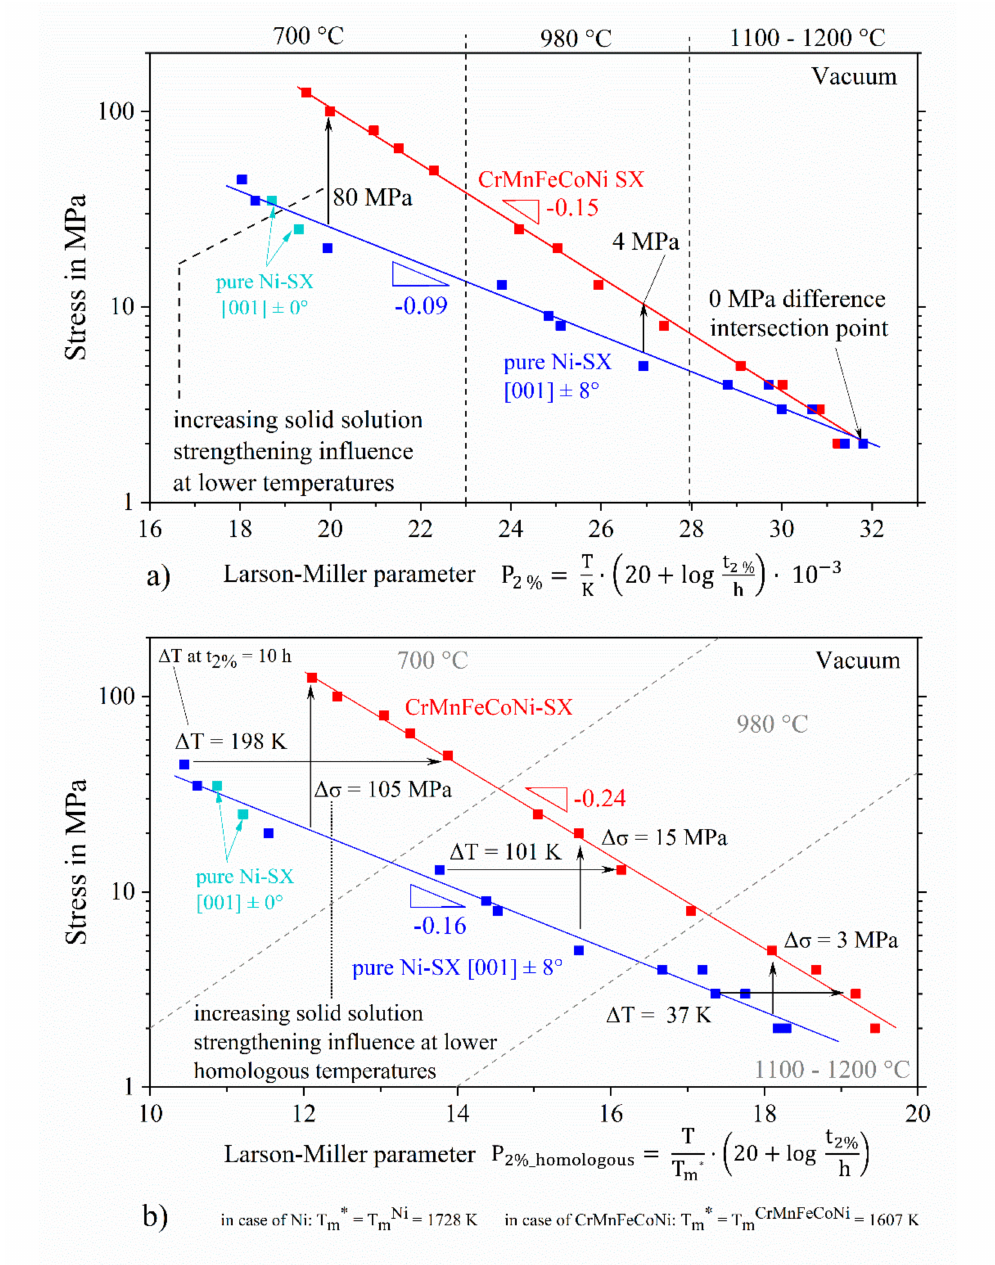
Figure 8. Larson–Miller plot of the CrMnFeCoNi alloy compared with pure nickel under vacuum: ( a ) using absolute temperature, and ( b ) using homologous temperature. The time to reach 2% strain was used to calculate the Larson–Miller parameter P 2% and P